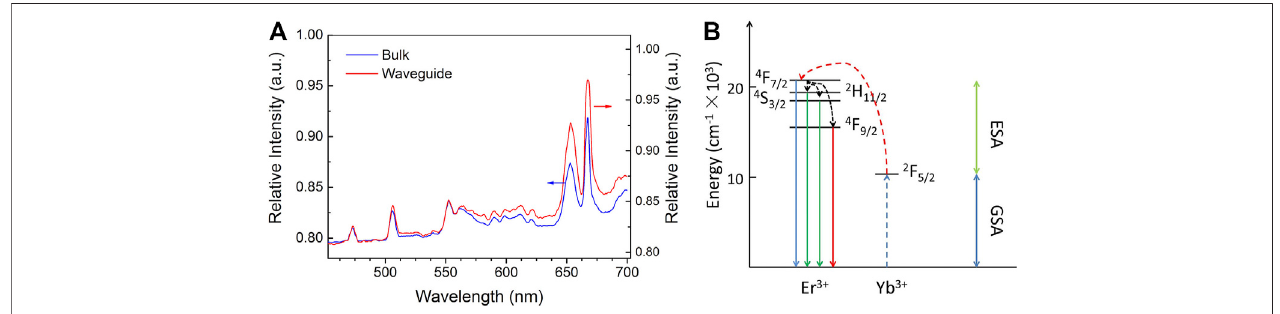
FIGURE 6 | (A) Up-conversion emission spectra detected in the bulk material and waveguides. (B) Diagram of the up-conversion emission under 980 nm